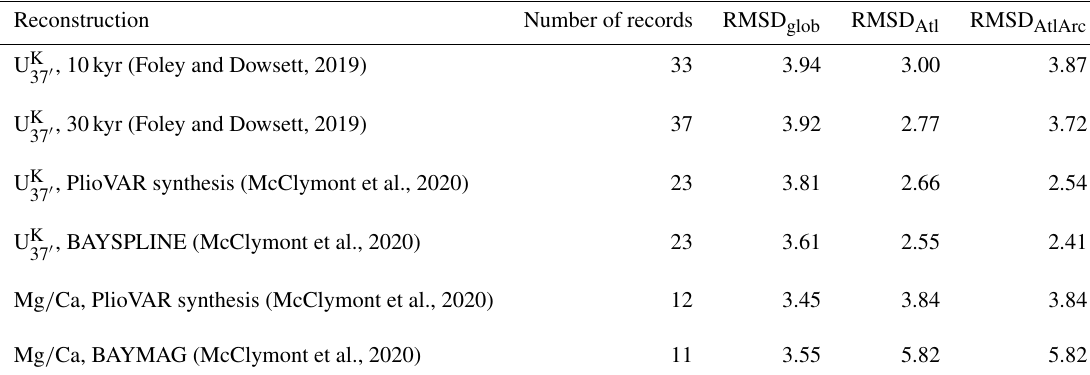
Table 8. Vegetation shifts at Northern Hemisphere high latitudes simulated by the dynamic vegetation module of JSBACH depending on carbon dioxide concentration. Shown are simulated shifts for three climate states with contemporary (E400, E560, and E600) and five climate states with mid-Pliocene (Eoi280, Eoi350, Eoi400, Eoi450, Eoi560) geography. Illustrated are spatial shifts in the tree line, which is arbitrarily defined here as the isoline of 15% tree cover, for four different regions: western Canada (WC), eastern Canada (EC), Greenland (G), and eastern Siberia (ES). We specify the northward shift for WC, EC, and ES, and the eastward shift for G. Absolute geographical coordinates of the tree line are provided in degrees longitude–latitude, and the shift of the tree line (in brackets) with respect to simulation E280 is provided in kilometres. For reference, the geographic location of the tree line in simulation E280 is given as well. Note that the tree line location is spatially very variable within the regions (Fig. 25). In simulations with high concentrations of carbon dioxide, the tree line defined here is absent as it reaches beyond the northern margin of the continent. This is reflected by the absence of a further shift in simulations with higher carbon dioxide.